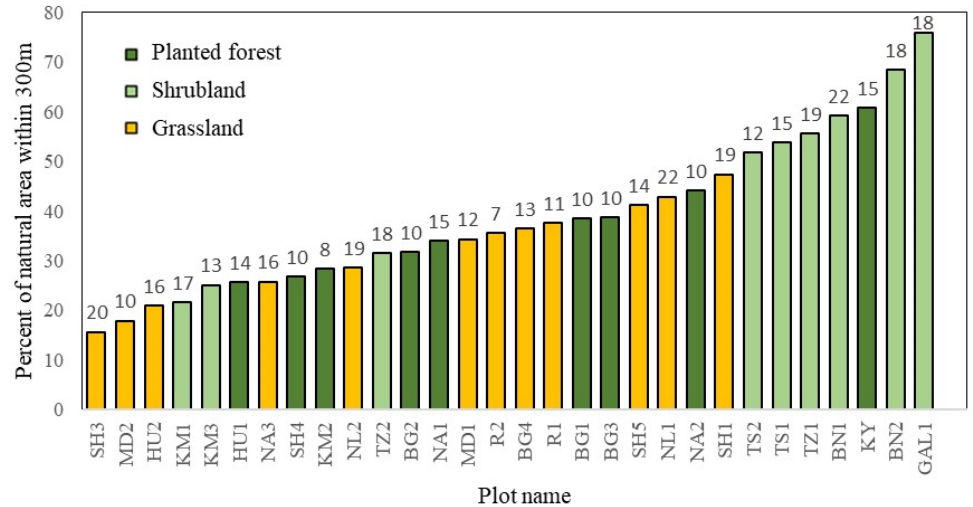
Figure 1. Study plot types along the gradient of the percentage of natural area within a 300 m radius buffer (from lowest to highest). Numbers on top of bars represent number of bee species collected in each plot. The order of plots and habitat type distribution along the land-use gradient were similar in the other tested radii (see Table S1).